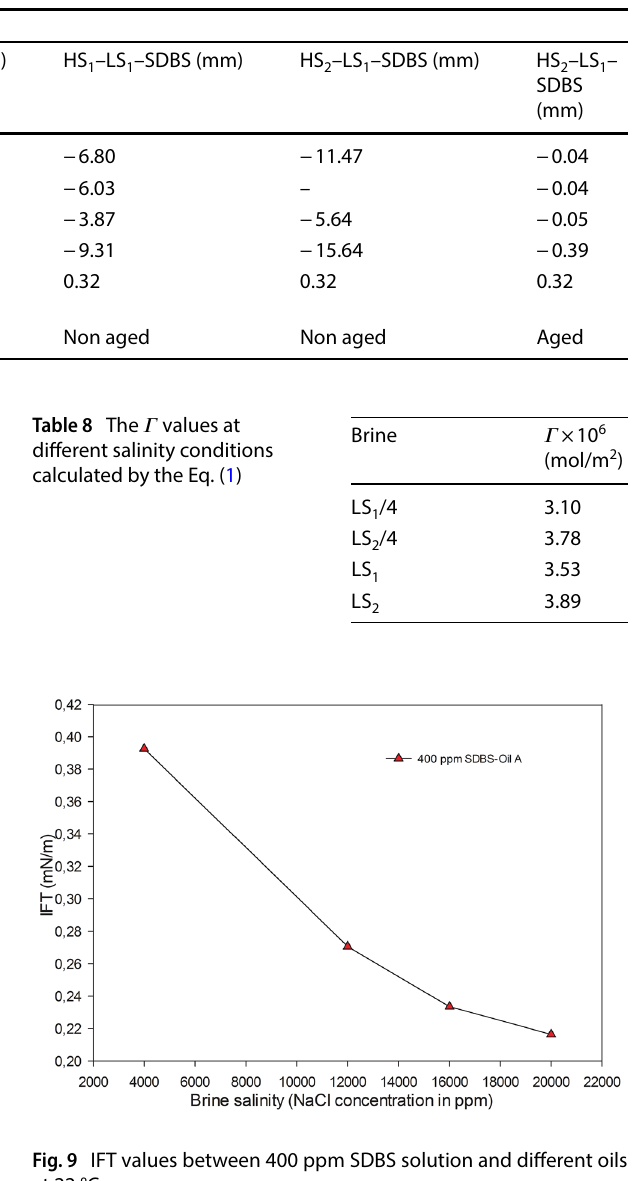
Fig. 9 IFT values between 400 ppm SDBS solution and different oils at 22